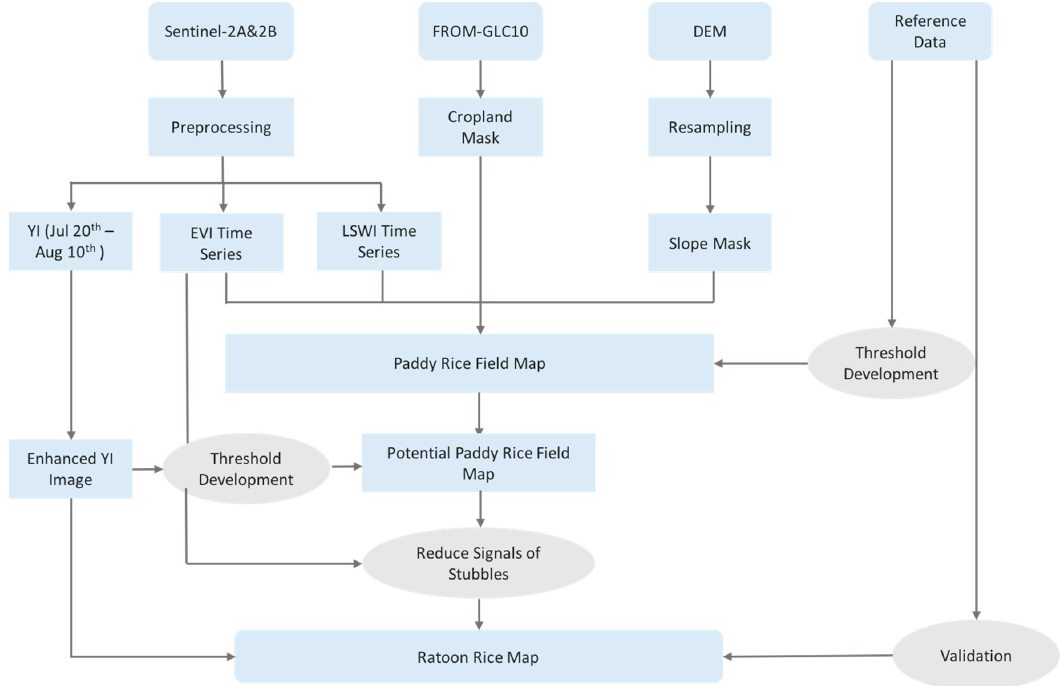
Figure 2. Workflow diagram illustrating the process of mapping ratoon rice.